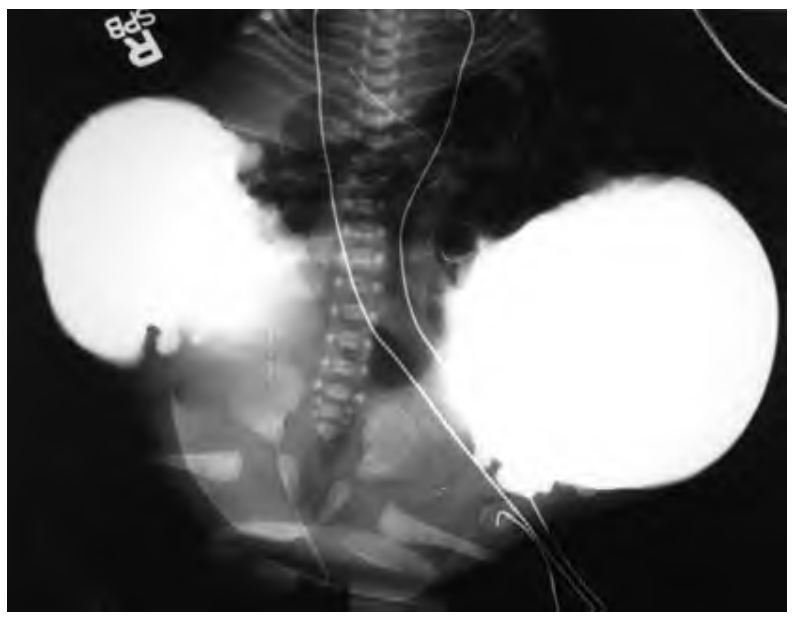
FIGURE 1 . Cystogram demonstrating severe bilateral reflux of contrast into renal pelvis